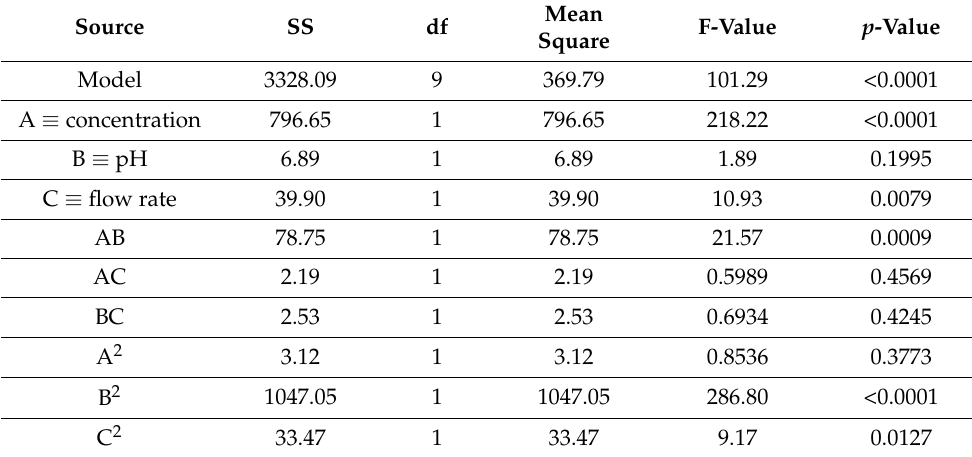
Table 3. Results of ANOVA for the experiments of Table